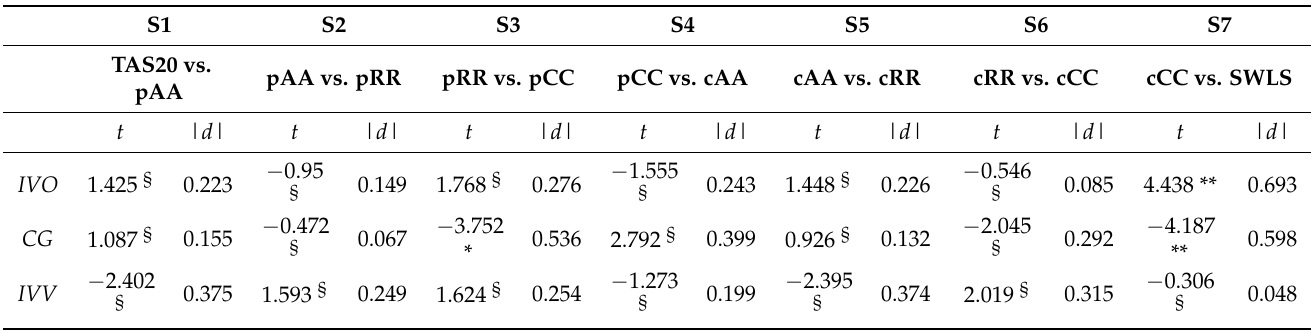
Table 3. Within-group